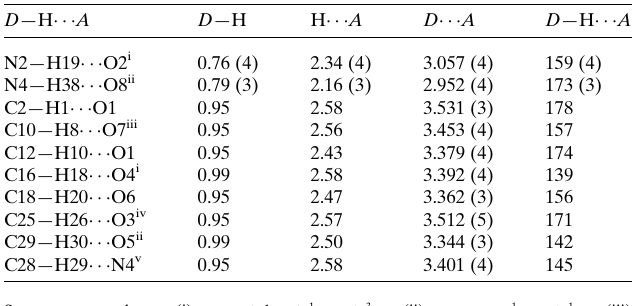
Table 2 Experimental details.